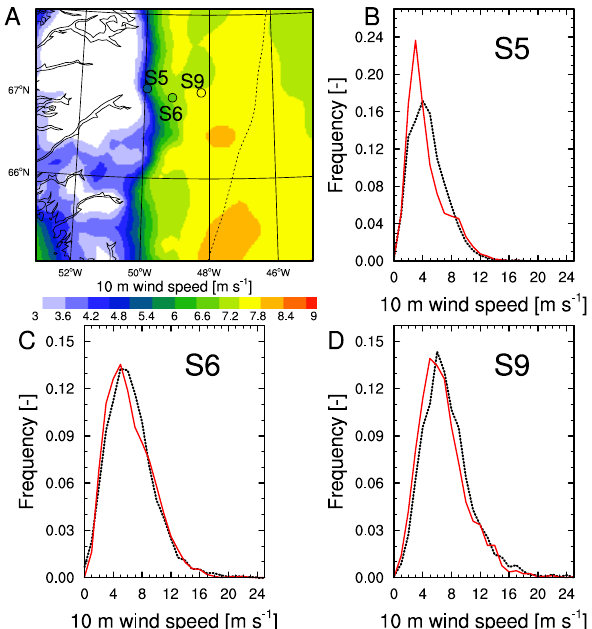
Fig.2. (B–D) Comparisonof10 m windspeedfrequencydistribu- Fig. 2. (B – D) Comparison of 10m wind speed frequency distribu- tionsfromRACMO2(red)andfromobservations(black),basedon tions from RACMO2 (red) and from observations (black), based on dailyaveragesfromtheperiod2003-2010at3AWSstationsalong theK-transect.AWSlocationsareshowninpanel (A) ,includingthe daily averages from the period 2003–2010 at 3 AWS stations along meanmodeled(background)andobserved(dots)10 m windspeed. the K-transect. AWS locations are shown in panel (A) , including the mean modeled (background) and observed (dots) 10m wind speed.